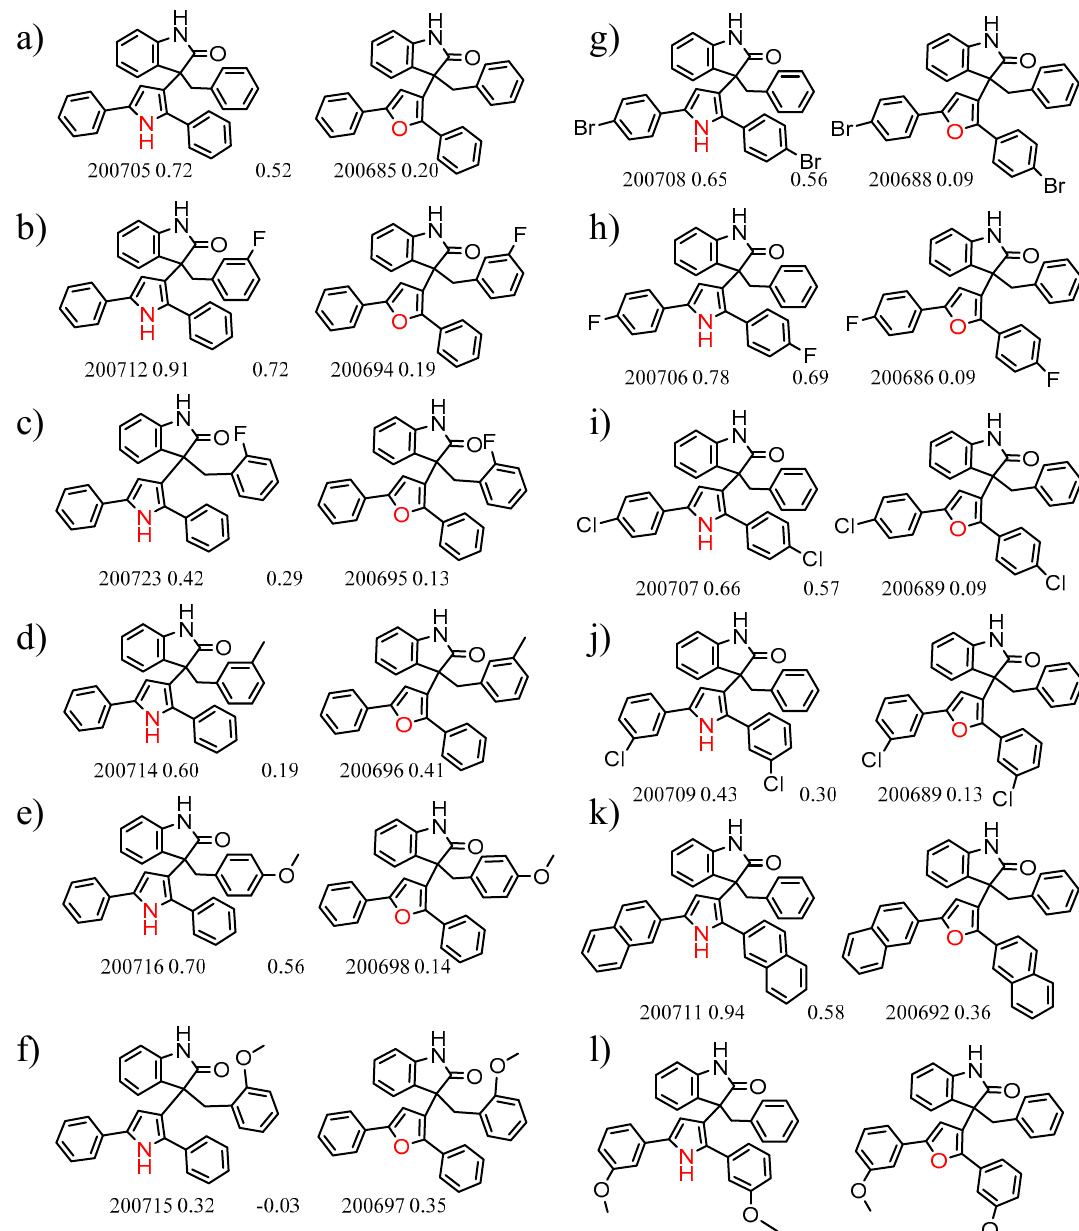
Figure 1. Expanded view of Cluster 1 for CSP_NO 23735 (Chiralpak-AD). There are 12 pairs (a–l) in this cluster. Differences in the structure are highlighted in red. Next to each compound is shown the Chirbase compound number and log( α ). The meanDiff within each pair is written between the molecules. This is an example of a cluster where all the values of α come from the same reference.